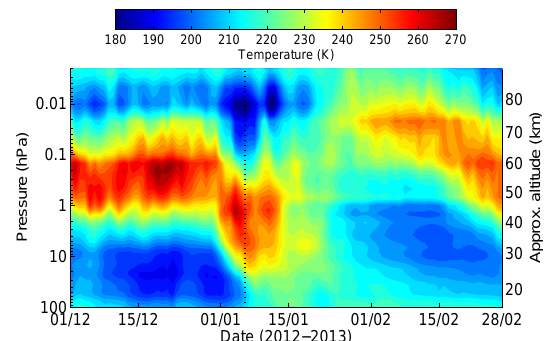
Figure 2. Polar cap zonal mean (70–80 ◦ N) temperatures for the 2012–2013 winter. The approximate altitude scale has been derived using CIRA-86 data (Fleming et al., 1990). The onset of the SSW is indicated by a dotted